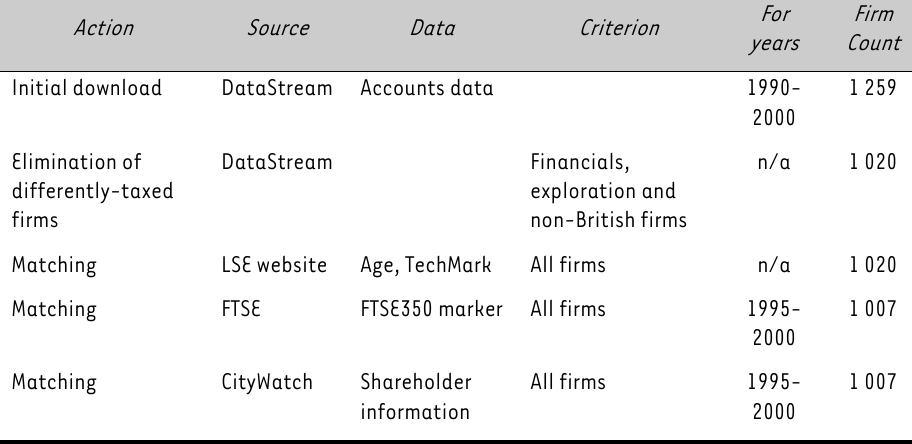
For Firm years Count